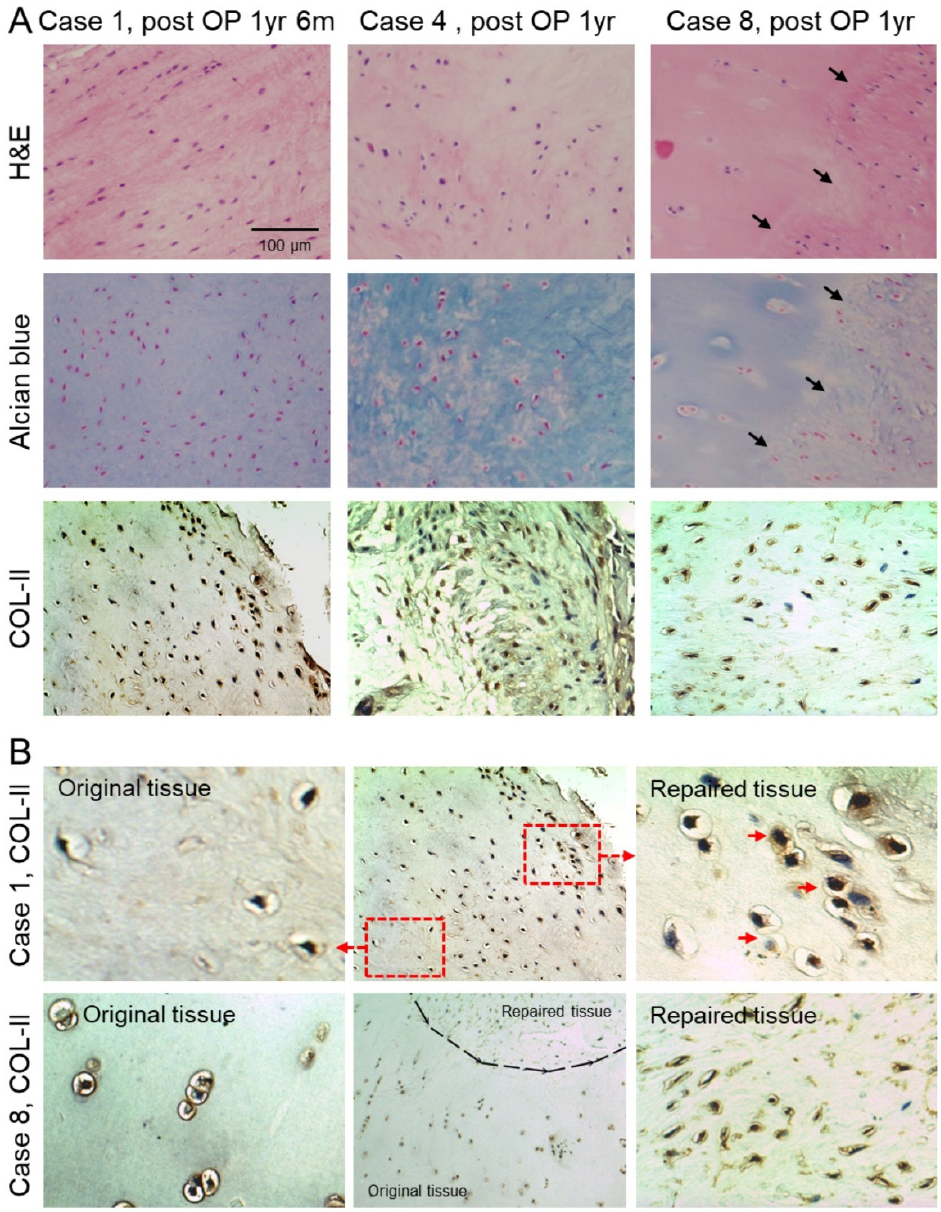
Figure 5. Histological analyses of biopsy specimens collected by the arthroscope. ( A ) Histological images of the biopsy specimens of three representative subjects (Cases 1, 4, and 8). The H&E staining, Alcian blue staining, and immunohistochemistry were performed to visualize the tissue morphology and expression levels of GAG/Collagen II (COL-II), respectively. The black arrows point out the integration of the implanted neotissues. ( B ) The immunohistochemical analysis for COL-II in the implanted cartilage tissue from Cases 1 and 8 demonstrate the integration of the implanted CPs into the original cartilage at the recipient sites. Compared with the original cartilage tissue, the CPs were relatively smaller in size and denser in number, and some of them showed lacuna development (red arrows) 1.5 years after the CP implantation.